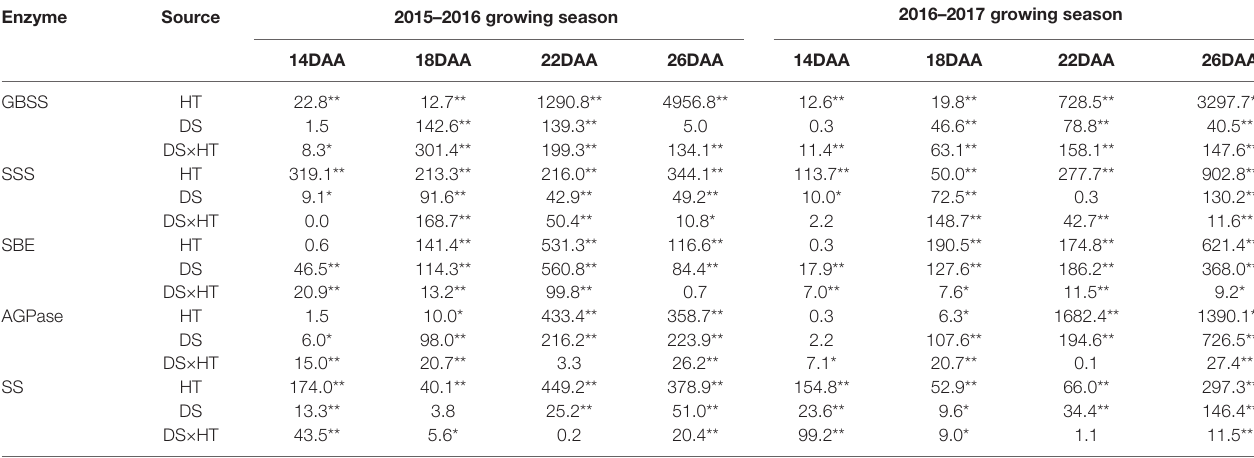
TABlE 2 | Variance analysis of the interaction of high temperature and drought stress and the activities of key starch biosynthesis enzymes. Enzyme